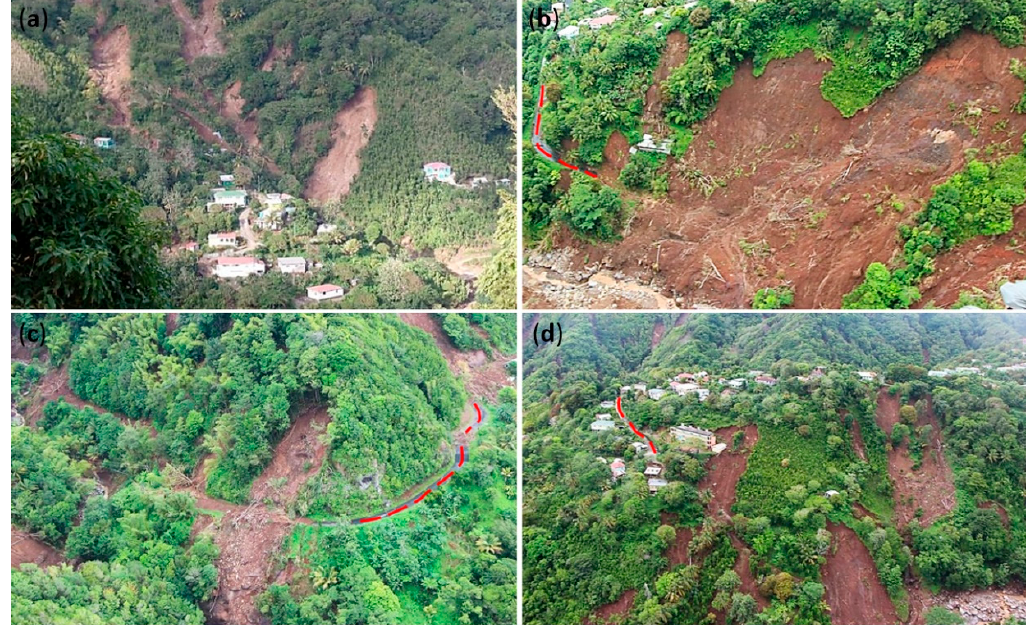
Figure 1. Landslides triggered from Tropical Storm Erika in the village of Petite Savanne. ( a ) is from [12], while ( b – d ) are from [13]. The roads have been highlighted with red-dashed lines to illustrate the impact on the transportation infrastructure.